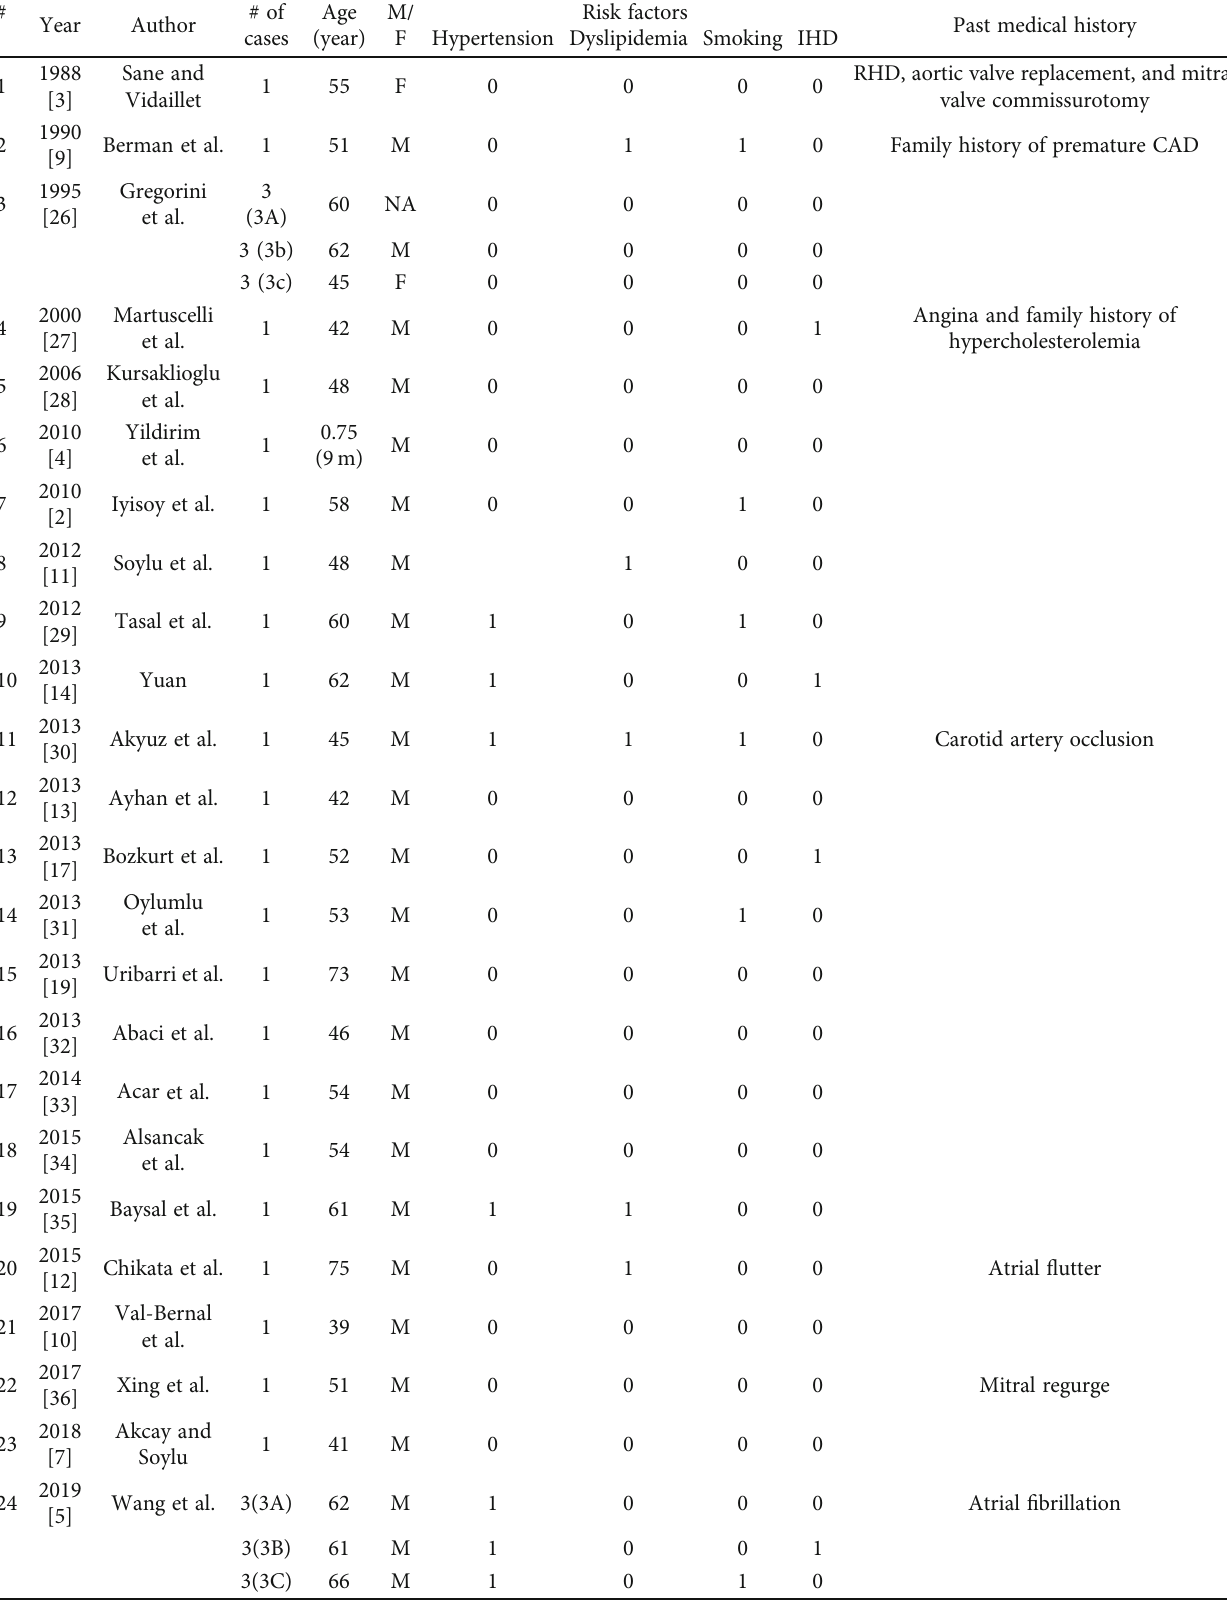
Table 1: A compiled list of case reports published in the literature and demographic ’ s